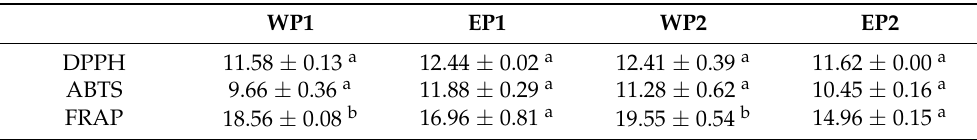
Table 8. Antioxidant activity of pepper extracts by DPPH, ABTS, and FRAP (results expressed as mg TE/g d.w. with the average ± standard